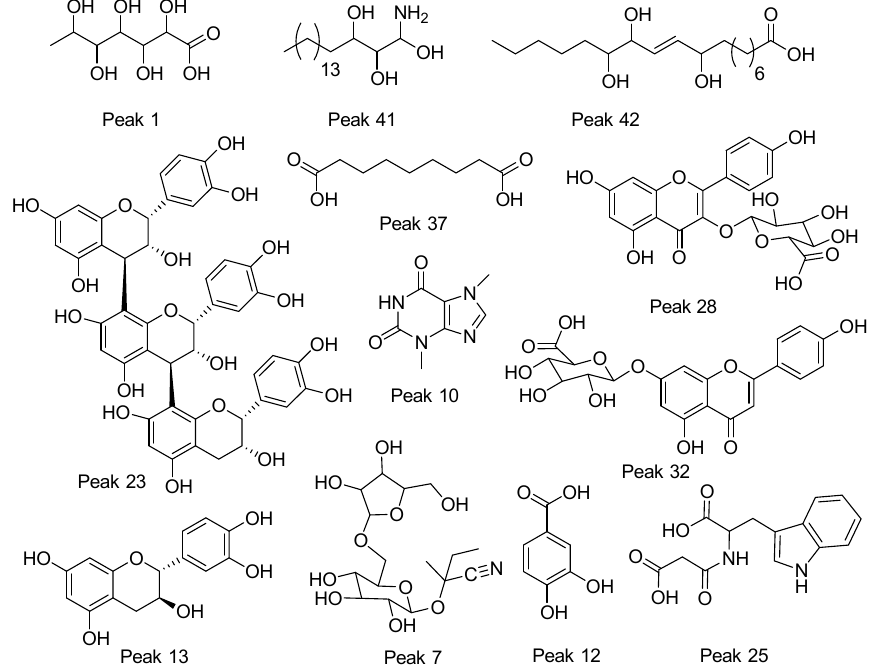
Figure 3. Structures of some representative compounds in vein and pod husk flours of cocoa.